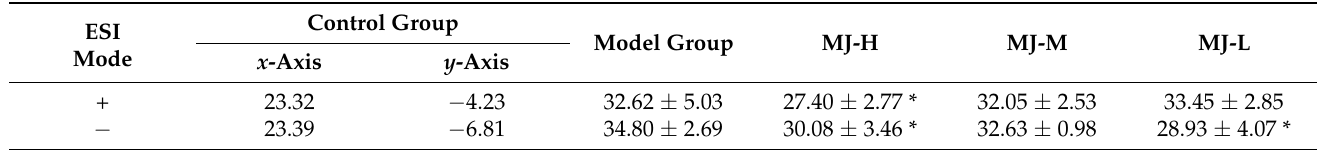
Table 1. The relative distances between the treatment groups and the control group from the OPLS– DA score plots of the plasma samples.